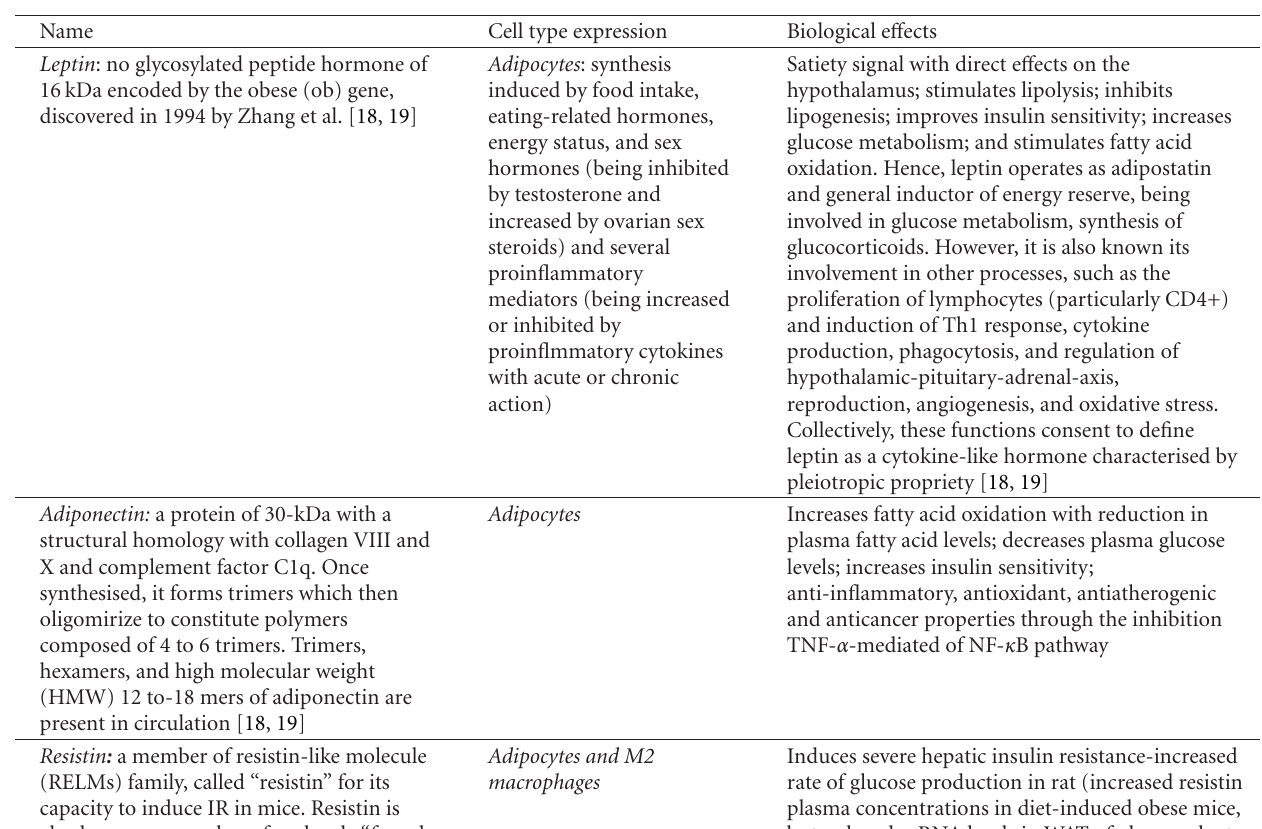
Table 1: Adipokines involved in energy